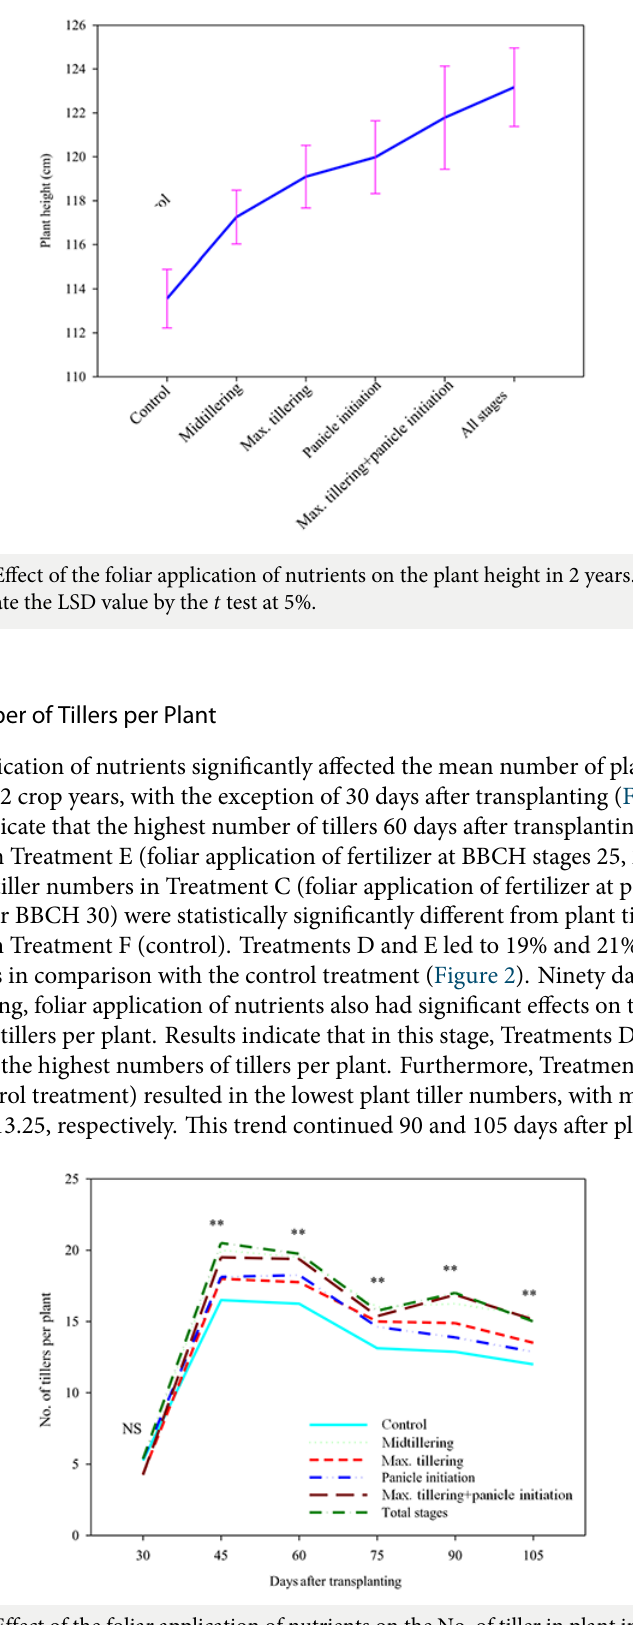
Figure 2 Effect of the foliar application of nutrients on the No. of tiller in plant in two agronomy years; NS and ** mean not significant and significant at 1% probability level,